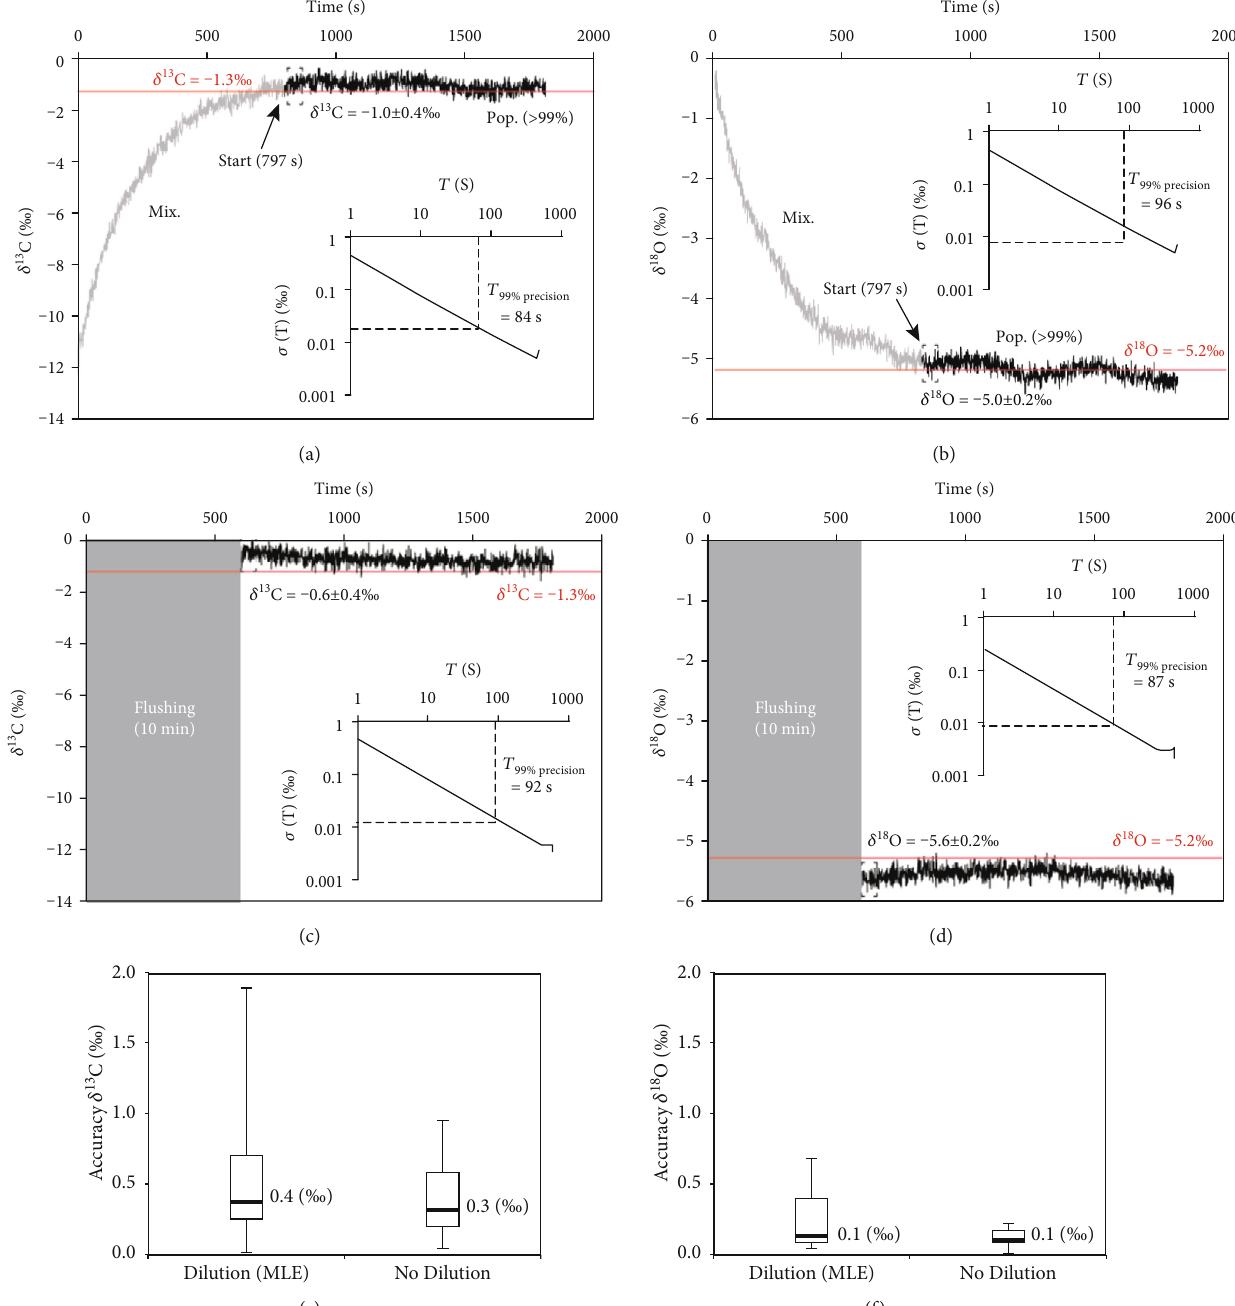
Figure 3: Raw signal (1 Hz) and overlapped Allan deviation using a fi xed range dilution system (yellow tube) obtained for 1800s of measurements for δ 13 C (a) and δ 18 O (b) and with an additional fl ushing time of 600 s before the measurements of δ 13 C (c) and δ 18 O (d). Red values and lines represent the theoretical signal expected from the analyzed sampling bag. “ Pop. ” represents the gas population de fi ned by the sample gas targeted (with 99% of con fi dence) whereas “ Mix. ” represents the gas mixture within the cell and the tubes measured at the beginning of the acquisition (see text for explanations). Dashed square represents the subset of measurements (on a time τ required to obtain 99% of the precision) used to calculate the average value used for the test of accuracy. Box-and-whisker plots for the deviations of δ 13 C (e) and δ 18 O (f) measured values from theoretical values of reference gases used in this study (see Methods and Appendix 1). “ MLE ” refers to the accuracy of the subset of measurements (with the dilution system) belonging to the population of interest (Pop.) obtained using the maximum likelihood